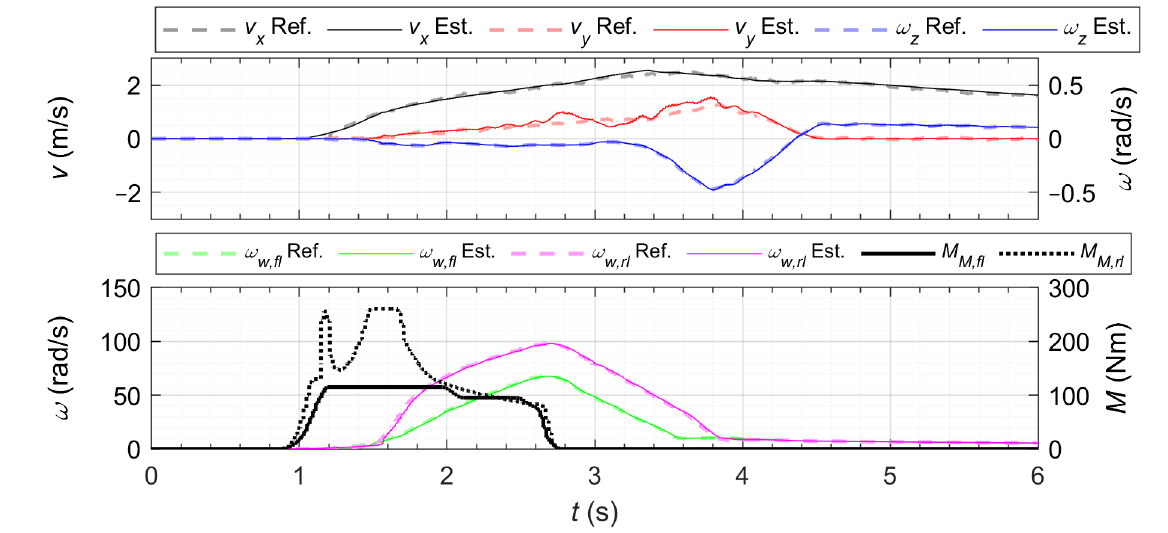
Figure 3. Test data—acceleration on a wet road surface: measured and estimated velocities, yaw rate, wheel speeds, and motor torques for front left and rear left